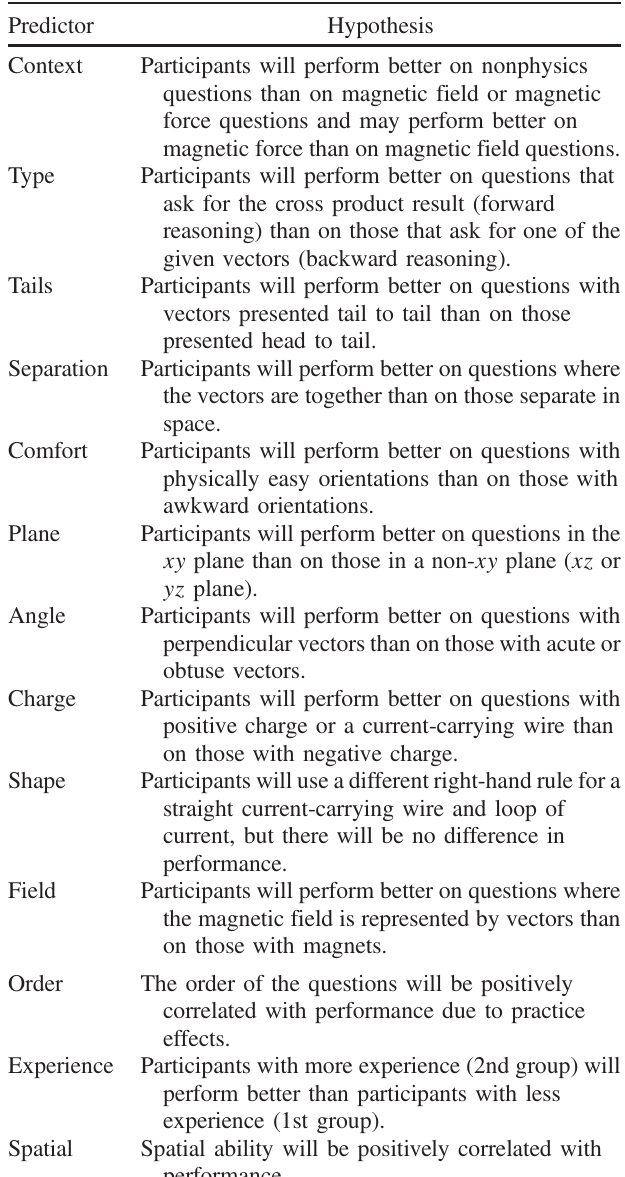
TABLE I. Hypothesized impact of predictors on performance. All except the last three (which serve as control variables) are shown in light blue in Fig. 1. Angle, Charge, Shape, and Field were treated separately in the quantitative analysis due to the constraints of the